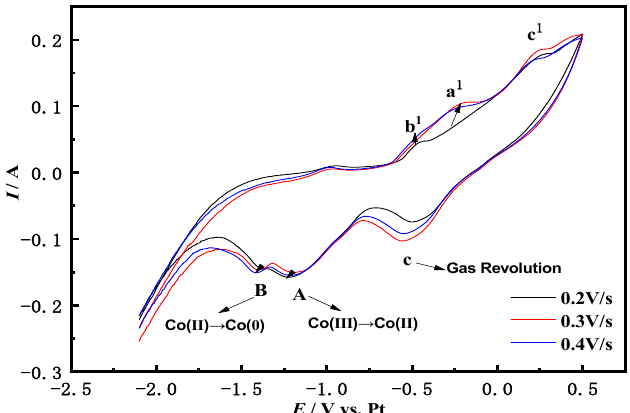
Figure 2. NaCl-CaCl 2 -LiCoO 2 molten salt system multi-cycle cyclic voltammetry (0.2–0.4 V/s; Fe electrode).